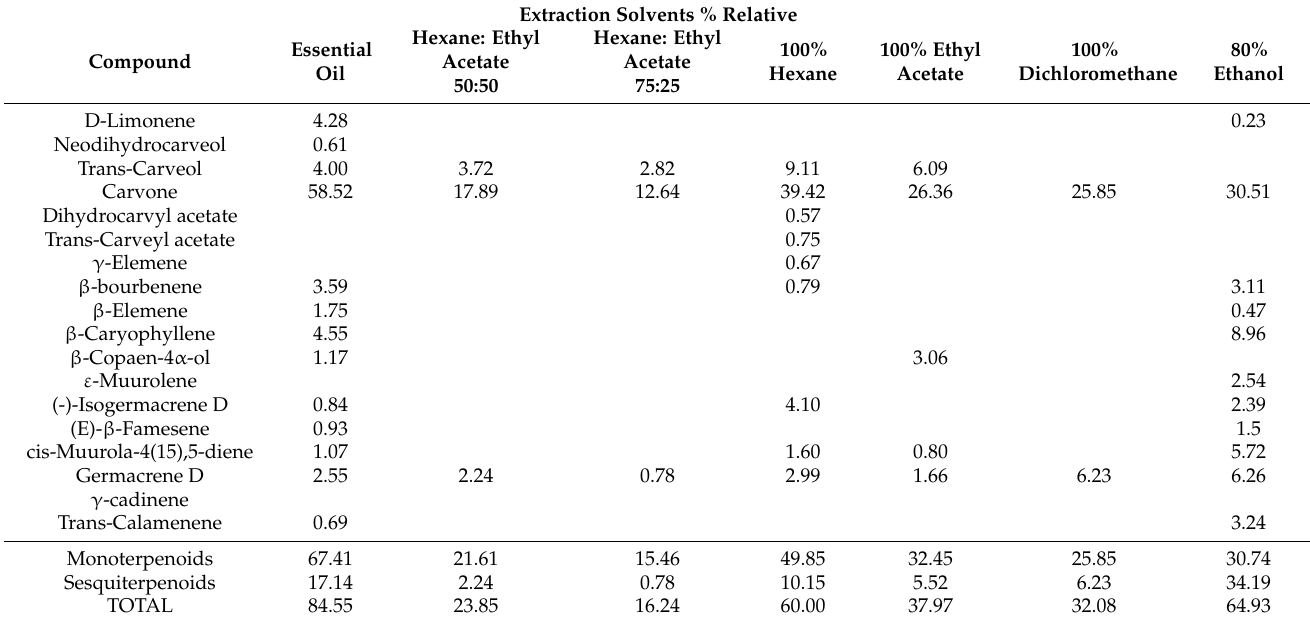
Figure 1. Selection of extraction system. Total polyphenols (TPC) ( A ), and rosmarinic acid con- tent (RA) ( B ), in extracts obtained with different proportions of solvent (mg of the compound or mg of gallic acid equivalents (GAE) per gram of dry sample or extract). Statistical analysis uses a one-way ANOVA (Bonferroni test, p < 0.05). Equal letters means that there is no statistically significant difference. Table 1. Chemical composition of the different M. spicata sample extraction